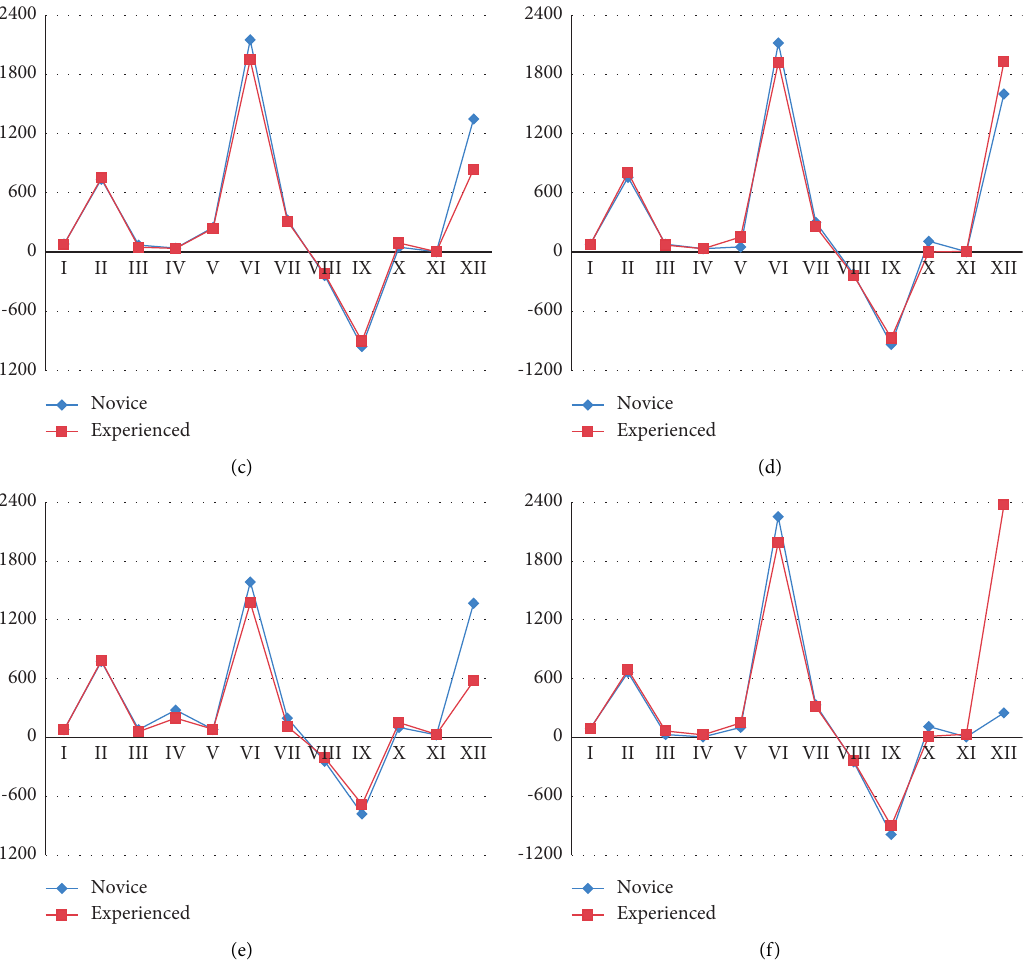
Figure 14: Novice and experienced drivers’ ECG characteristics in anxiety. (a) Female ∗ 45–50 years old ∗ extraversion. (b) Female ∗ 45–50 years old ∗ middle type. (c) Female ∗ 45–50 years old ∗ introversion. (d) Male ∗ 45–50 years old ∗ extraversion. (e) Male ∗ 45–50 years old ∗ middle type. (f) Male ∗ 45–50 years old ∗ introversion (I, AVHR; II, AVNN; III, SDNN; IV, PNN 50 ; V, RMSSD; VI, RWAVE; VII, TWAVE; VIII, Q; IX, S; X, UVLF/VLF ∗ 1000; XI, LF/HF ∗ 100; XII,